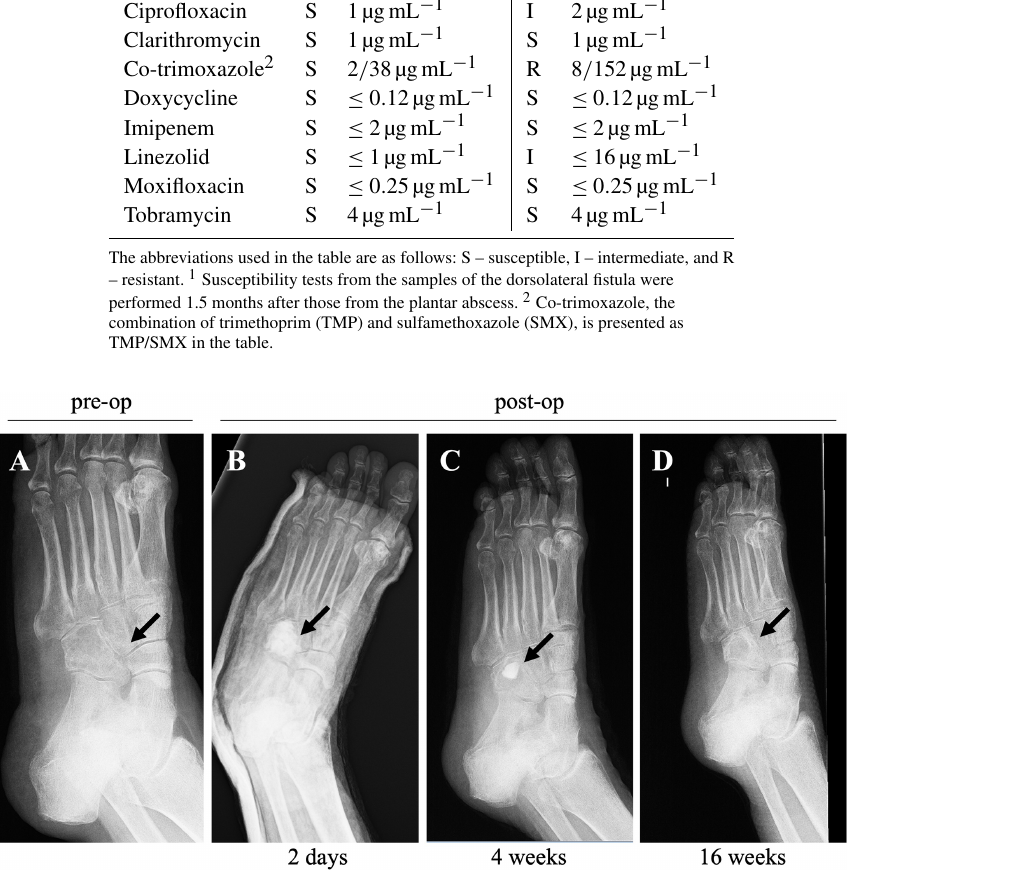
Figure 3. X-ray (medial oblique view) images taken before and after the surgery: (a) an X-ray image taken before surgery, and X-ray images taken at 2d (b) , 4 weeks (c) , and 16 weeks (d) post-surgery, showing the resolution of inflammatory and infectious parameters, correct healing, and the evolution of soft